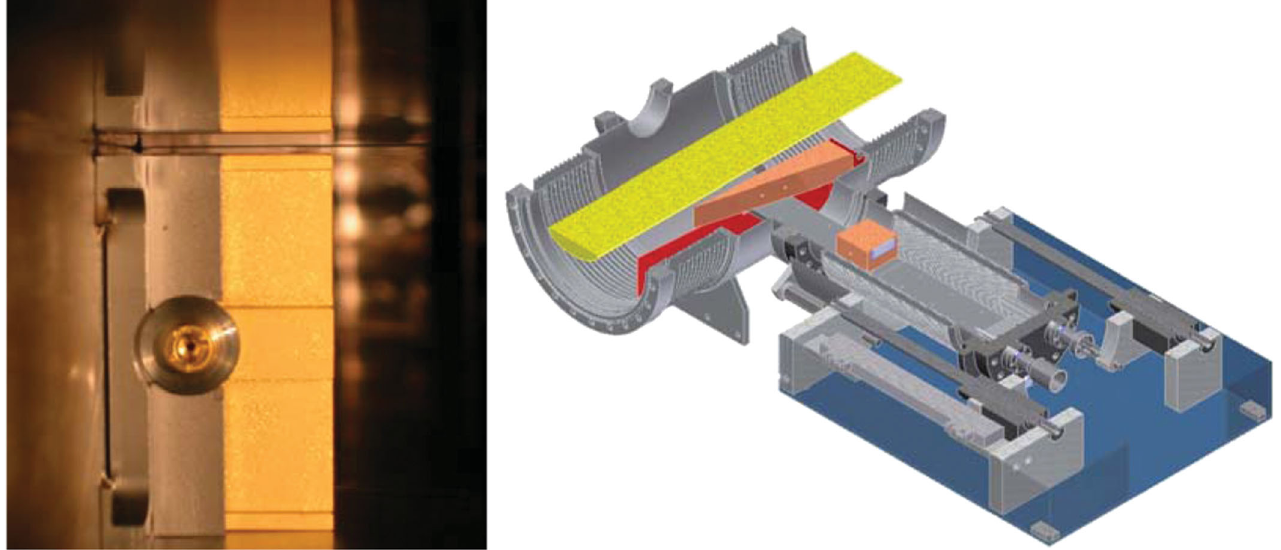
FIG. 6. (Color) Left: Photograph of a 30 (cid:3) m gold-coated 316LN stainless steel collimator to collect lost 4 : 2 MeV = u Pb 53 þ ions. The collimator is screwed on the back face onto a stainless steel support which is spot welded at the end of each LEIR bending magnet vacuum chamber [14]. Right: Horizontal cut through the installed SIS 18 ion-catcher prototype. Yellow: beam; red: secondary chamber; brown: beam absorbers